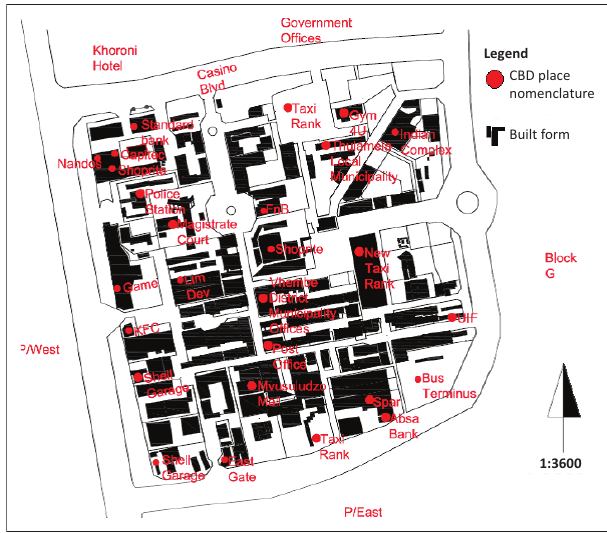
FIGURE 2: Central business district place nomenclature. CBD, central business district.